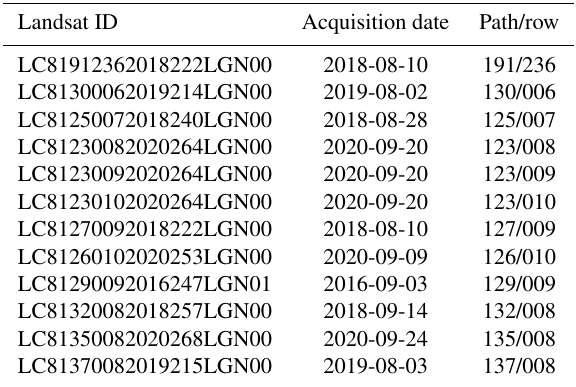
Table B1. Landsat 8 scenes used for calculating the NDWI.